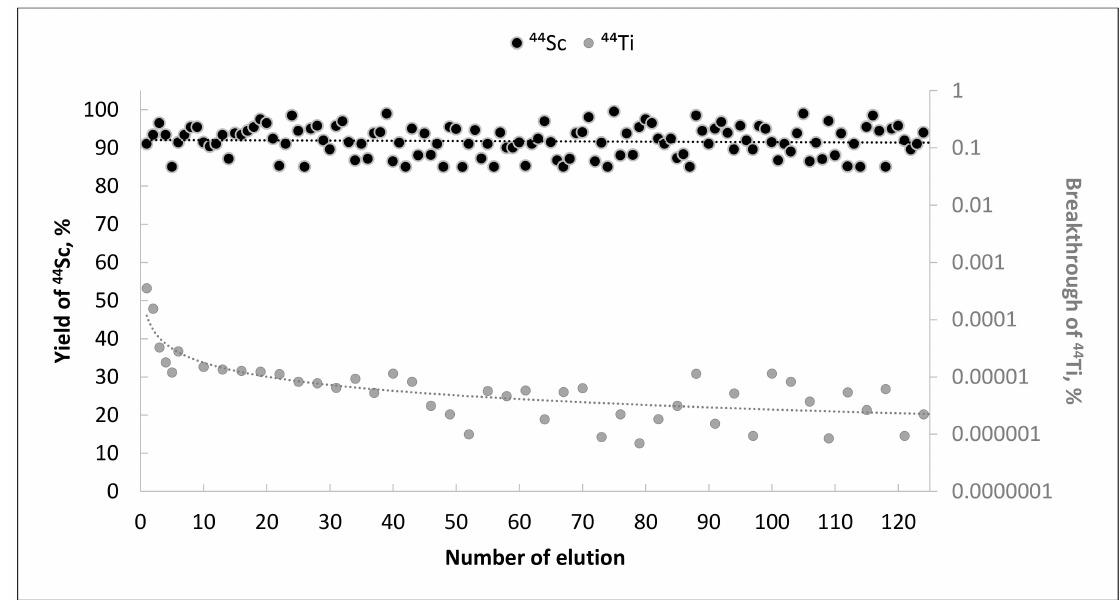
Figure 4. 44 Sc elution yield (primary axis) and 44 Ti breakthrough (secondary axis) for TEVA resin generator prototype for over 100 elutions (eluate volume—1 mL, flow rate—1 mL/min, eluent—0.1 M H 2 C 2 O 4 /0.2 M